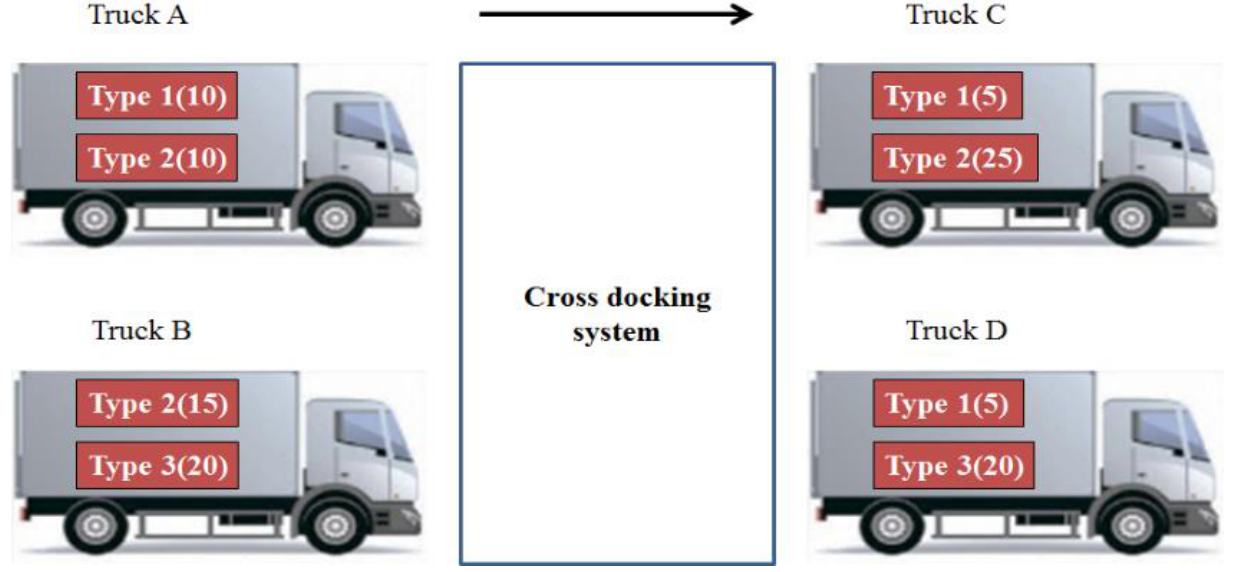
Figure 1. Example of truck pairs matching.